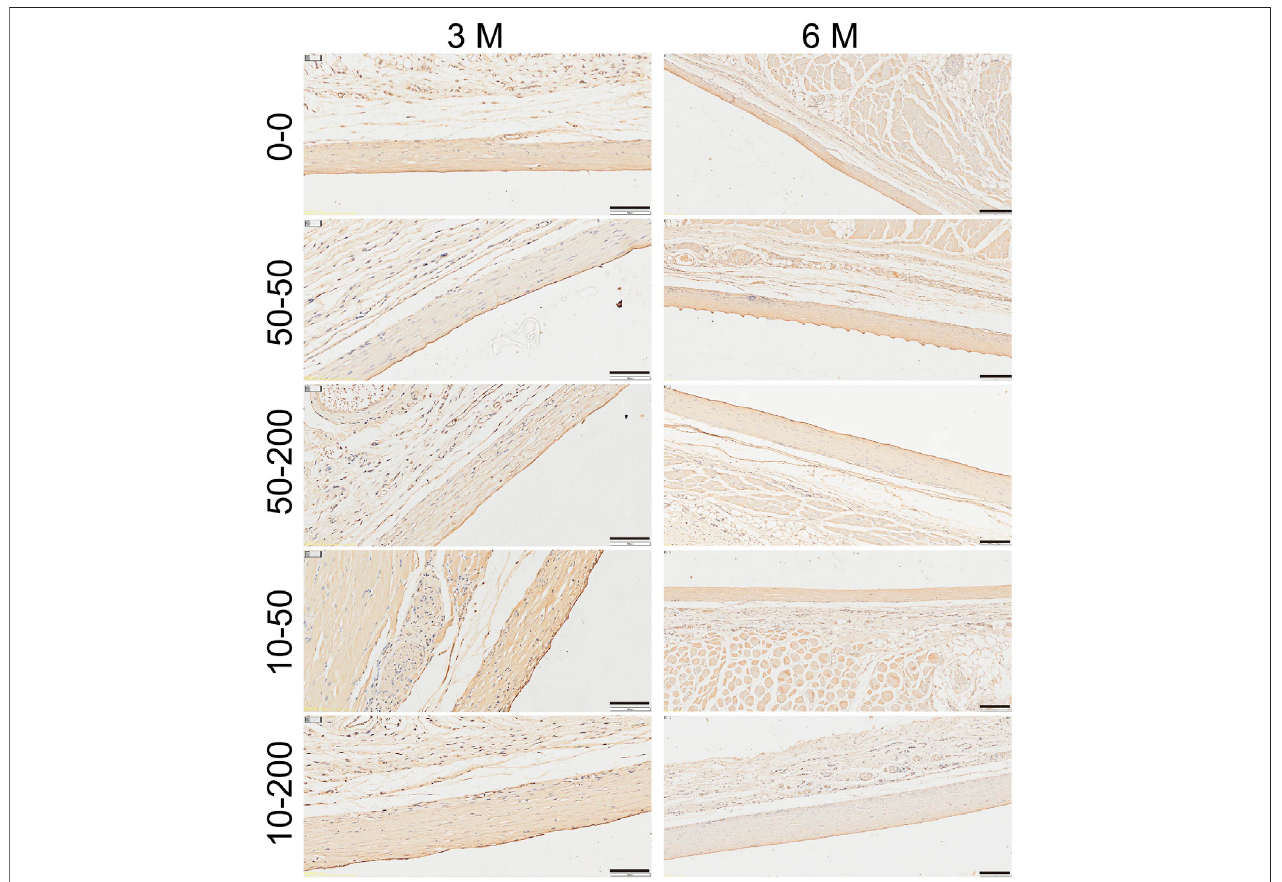
FIGURE 11 | Effect of material surface topology on capsule contracture. Representative results of elastin staining (scale bar (cid:2) 200 μ m).